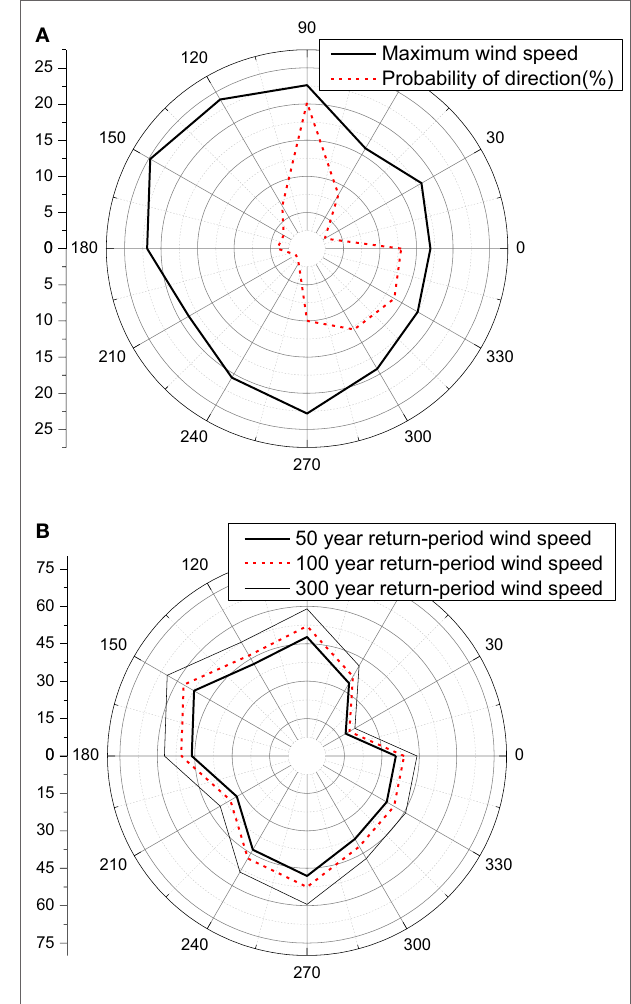
FigUre 4 | Wind speed and direction . (a) Maximum wind (m/s) and probability of direction. (B) Wind speeds (m/s) for different return periods.